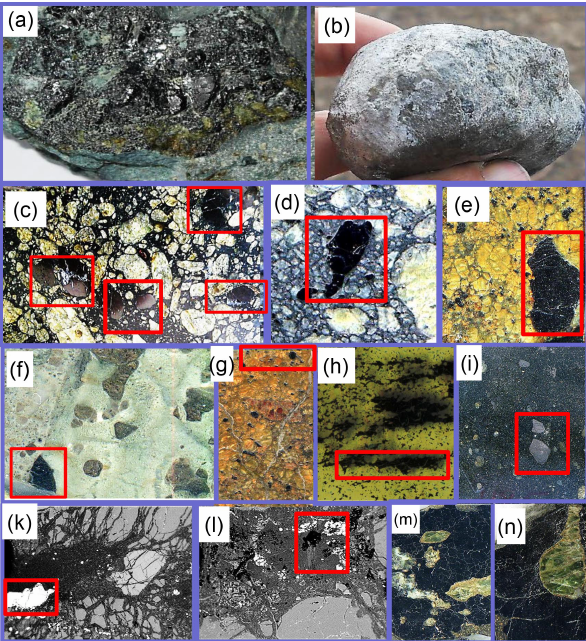
Figure 2. (a) Photograph of ilmenite megacryst in contact with peridotite (Sytykanskaya pipe, sample Stk1); (b) large megacrysts from the Dalnyaya pipe; (c) agglomerate of ilmenite megacrysts and dunite microxenoliths (rarely containing garnets, orthopyroxenes and clinopyroxenes) in kimberlite, Udachnaya pipe; (d) Ilmenite in kimberlite Sytykanskaya pipe; (e) wehrlite with large and small ilmenite grains (Sytykanskaya pipe); (f) image of the thin section of deformed peridotite with ilmenite, mica and clinopyroxenes in intergranular space (Sytykanskaya pipe, sample Stk35); (g) garnet ilmenite-bearing peridotite; (h) deformed peridotite with ilmenite grain (black) (Sytykanskaya pipe); (i) phlogopite breccia with il- menite xenocrysts, Udachnaya pipe; (k) and (l) ilmenite grains (bright) in thin section of porphyroclastic peridotite (Dalnyay pipe); (m) and (n) clinopyroxene inclusion in ilmenite megacrysts. Sepa- rate ilmenite grains are marked by the red